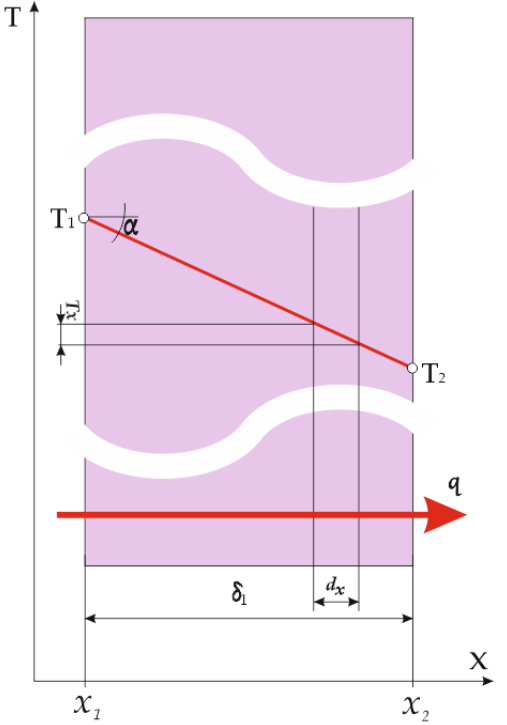
Figure 1. Temperature field for the flat thermal insulation layer for the case q = const.